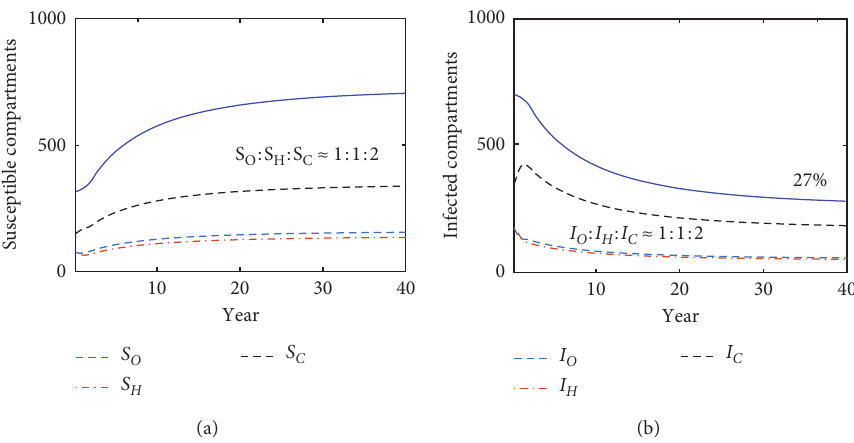
Figure 2: Dynamics of the six-equation model (1) with 70% initial prevalence. The final steady state (in solid blue line) prevalence is about 27% where the proportion of three states, offspring ( O ) , heifers ( H ) , and cows ( C ) , is about 1 : 1 : 2 in both susceptible and infected categories.